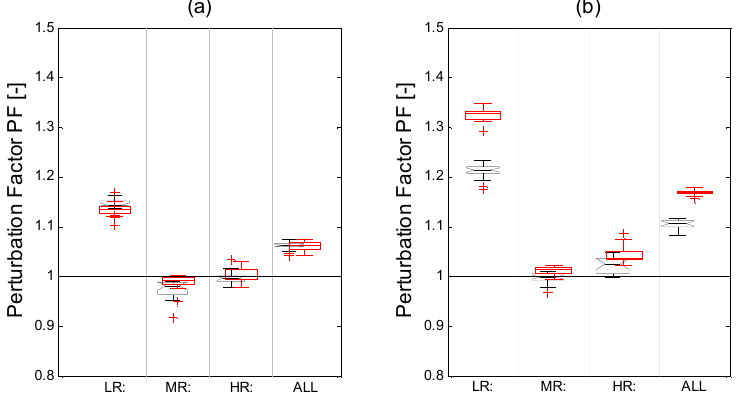
Figure 16. Comparison of mean perturbation factors for annual precipitation based on GCM resolutions for the 2040s (notched) and 2075s, ( a ) RCP4.5; ( b ) RCP8.5.